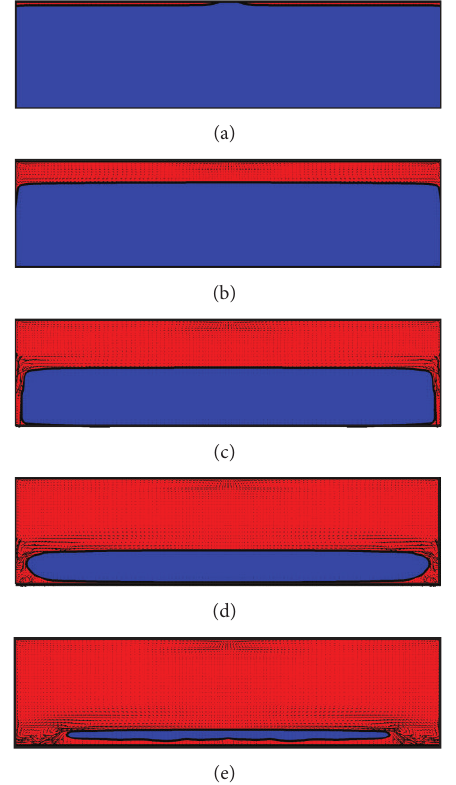
Figure 3: Melting process in conventional DS furnace for power distribution ratio of 5:5: (a) 480 min; (b) 540min; (c) 600min; (d) 660min; (e) 720min.